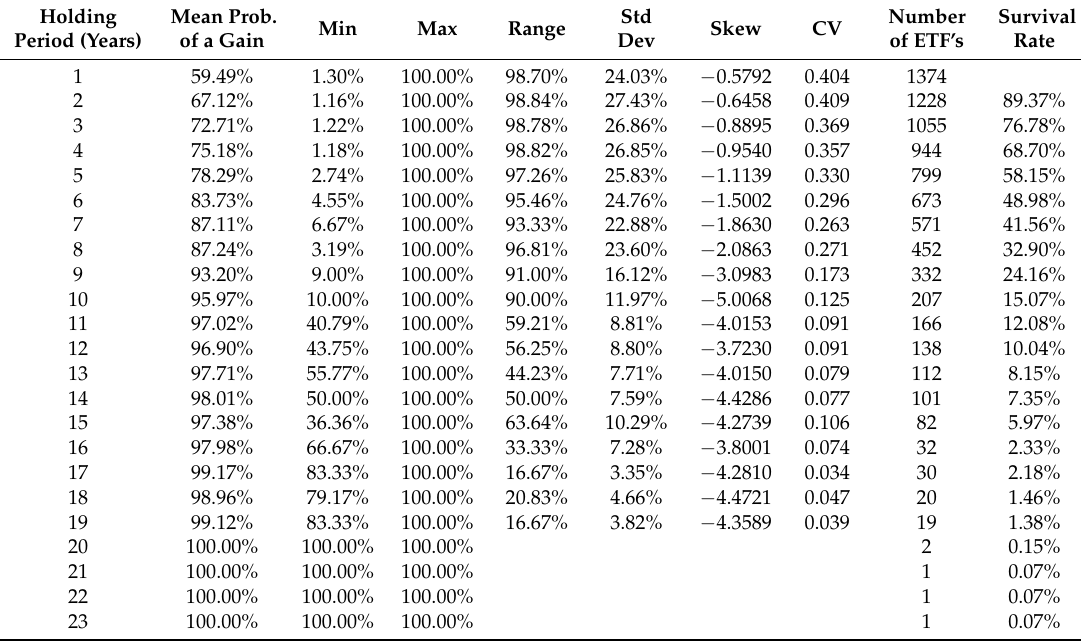
Table 2. Success Rates for All NASDAQ Exchange Traded Funds (ETF’s).